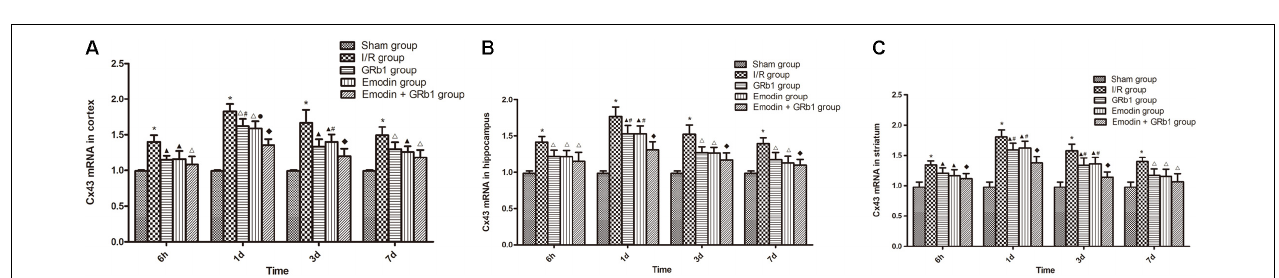
FIGURE 6 | The AQP4 mRNA expression in different groups after I/R in rats (mean ± SD, n = 5). (A) Cortex; (B) hippocampus; (C) striatum. Quantitative analysis for the results of groups at 6 h, 24 h, 3d, and 7d, respectively. One-way analysis of variance (ANOVA) was used for multiple group experiments comparisons and followed by Dunnett test for comparison of two groups within the multiple groups. ∗ p < 0.001, compared with Sham group. (cid:78) p < 0.05, (cid:77) p < 0.01, (cid:7) p < 0.001, compared with I/R group. • p < 0.01, compared with the Emodin+GRb1 group.